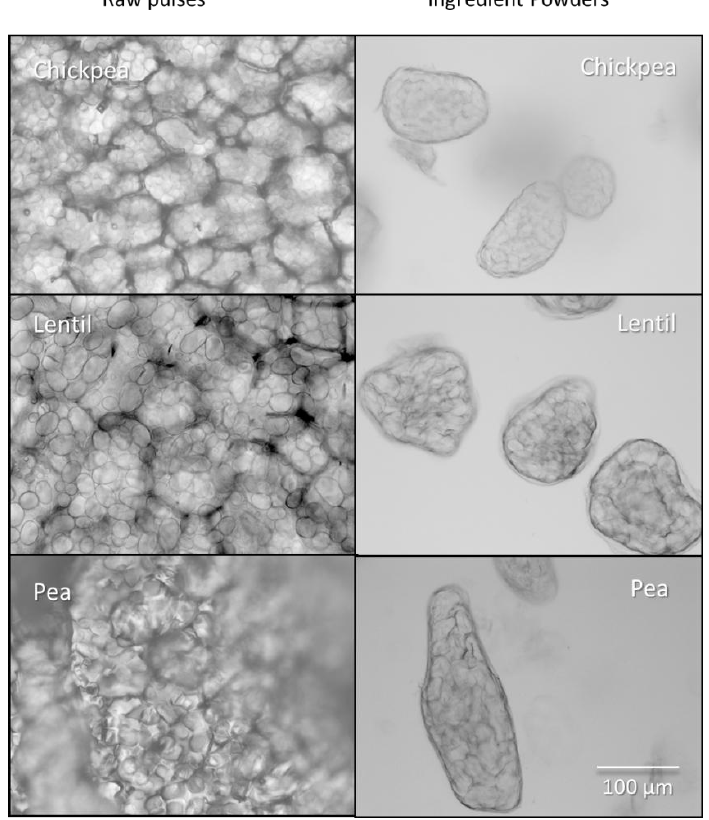
Figure 2. Bright field microscopy of raw pulses and spray-dried pulse